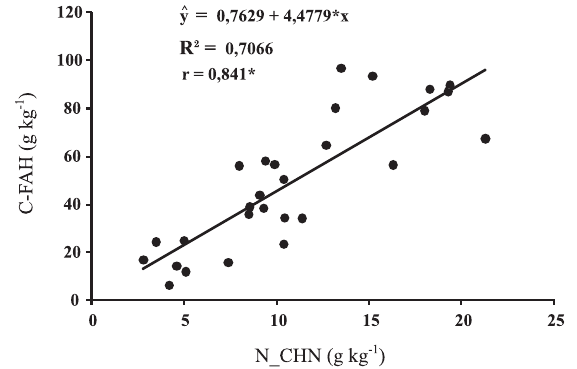
Figura 1. Relação entre os teores de N determinados pelo CHN e o carbono da fração ácido húmico (C-FAH)